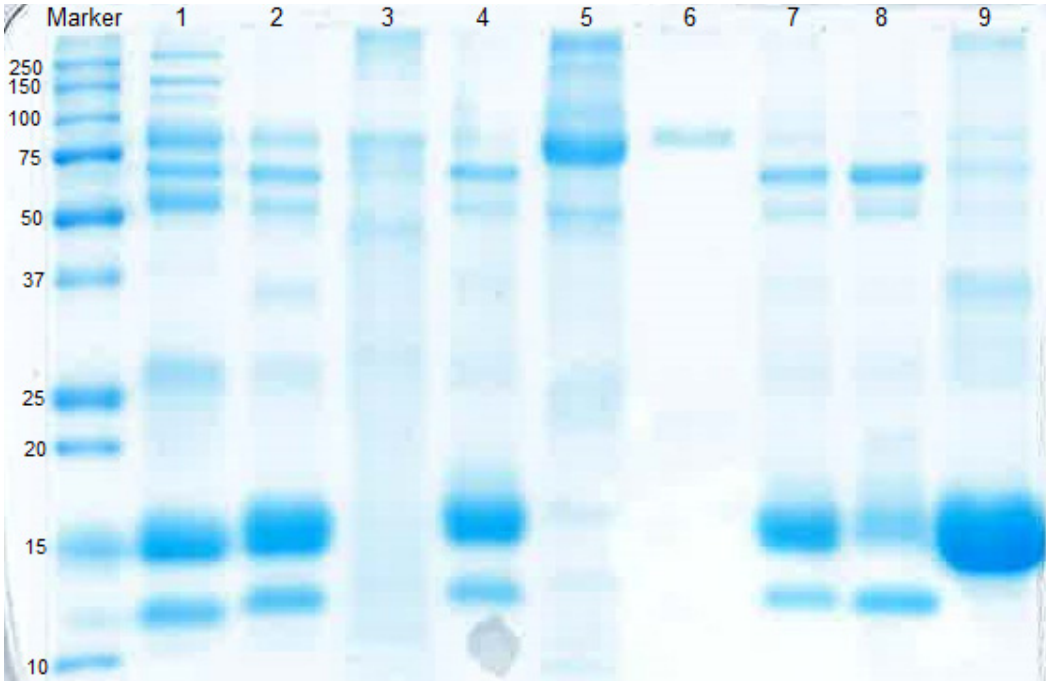
Figure 2. SDS-PAGE of cow and deer milk whey proteins. Lane 1: cow milk whey; lane 2: deer milk whey. Lane 3 – 9 are deer milk whey protein fractions from FPLC — lane 3: putative GMP from FPLC